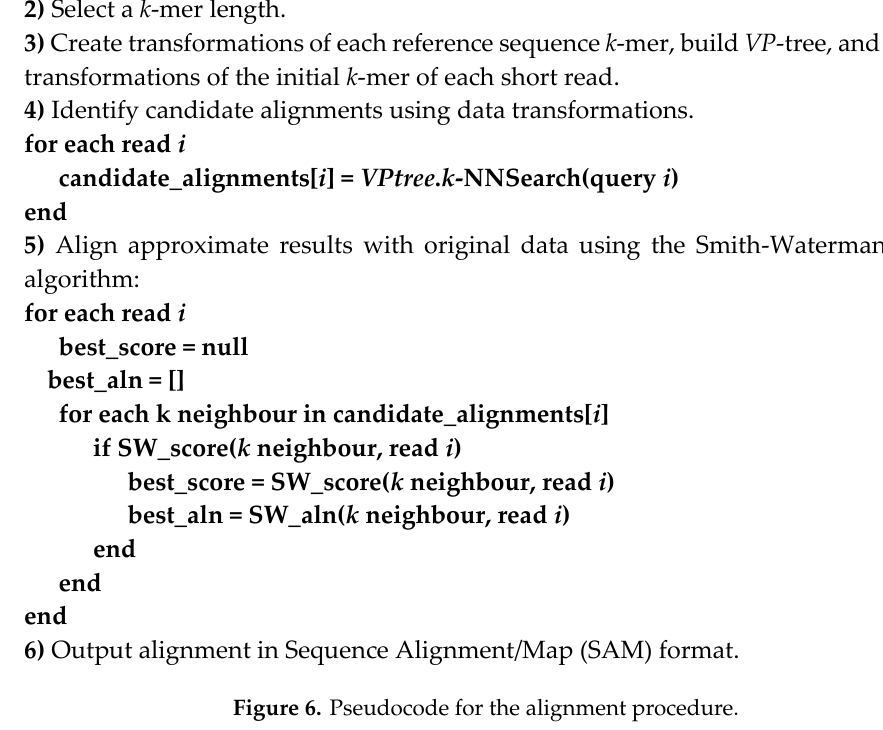
Figure 6. Pseudocode for the alignment